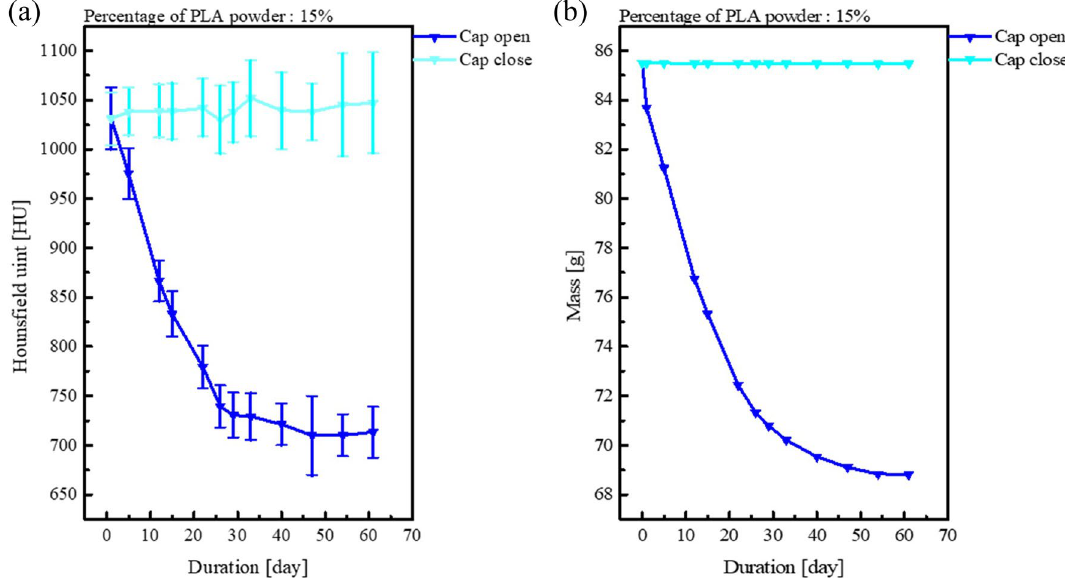
Figure 6. The differences in ( a ) HU and ( b ) mass over time with the conical tube open and closed.